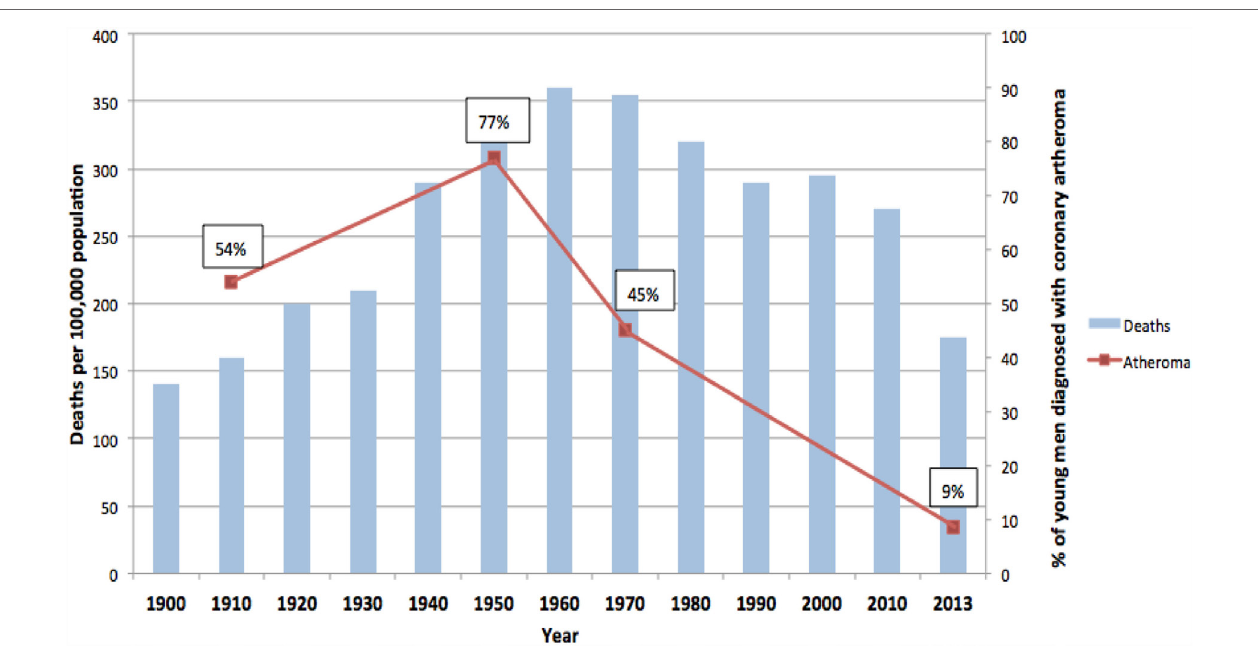
FiGURe 2 | Deaths due to coronary artery disease USA (blue columns). Coronary atheroma prevalence (red line). 100-year trends (9–12, 15).